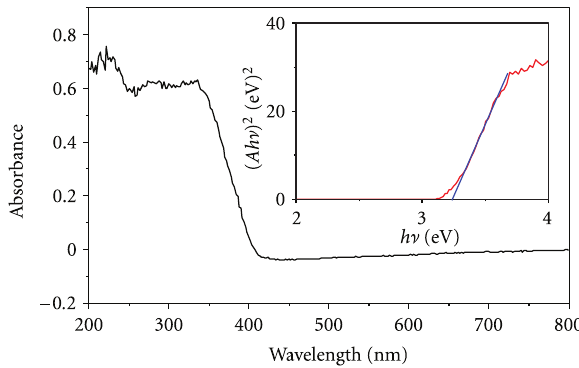
Figure 1: The UV-vis absorbance spectrum of TiO 2 photocatalyst. Inset shows the plot of ( Ahv ) 2 versus hv for TiO 2 , the straight line represents the extrapolation of the abscissa from the linear fit of the curve, through which the band gap was estimated at about 3.20